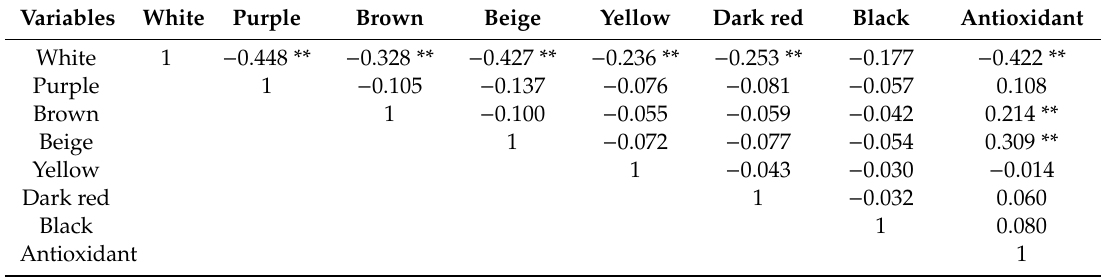
Table 3 . Distribution and linkage disequilibrium of DArTseq markers on different chromosome of common bean .